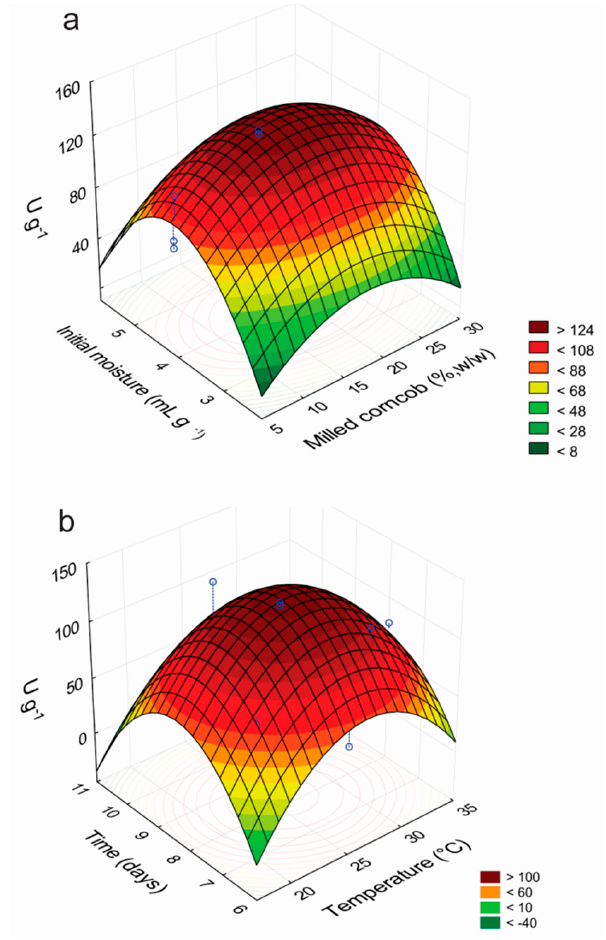
Figure 1. Response surface plots showing the interactive effects of initial moisture and milled corncob concentration ( a ), and temperature and culture time ( b ), on the production of laccases by P. sanguineus RP15.